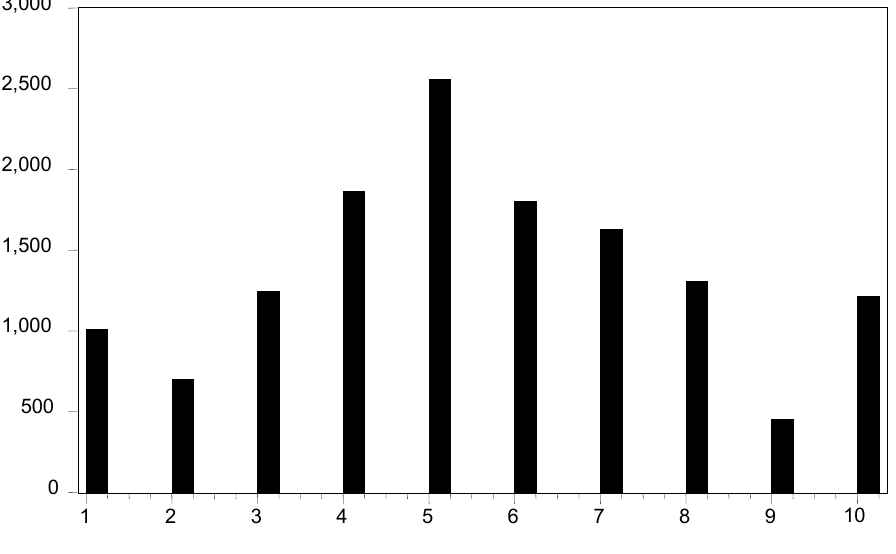
FIGURE 1: Distribution of Life-Satisfaction in South Africa, 2008 Source: NIDS